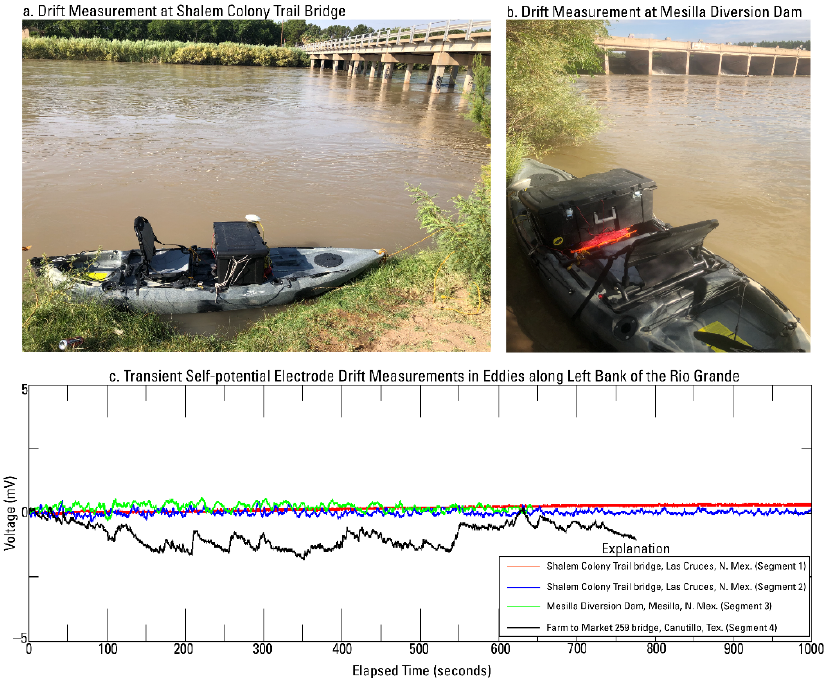
Figure 4. Electrode-drift measurements performed in eddies along the banks of the Rio Grande. ( a ) Photograph of the kayak equipped with GPS, power, and logging equipment used to make drift measurements (red and blue, panel c) at Shalem Colony Trail bridge in Las Cruces, New Mexico (N. Mex.) near the left bank (looking downstream toward the southwest). ( b ) Photograph of the kayak equipped with GPS, power, and logging equipment used to make drift measurements (green, panel c) at Mesilla Diversion Dam in Mesilla, N. Mex., near the right bank (looking upstream toward the northeast). ( c ) Electrode drift data measured for each survey segment used to determine electrode-drift corrections for gradient SP data. The start and end point of survey segments 1–4 are depicted in Figures 1–3.